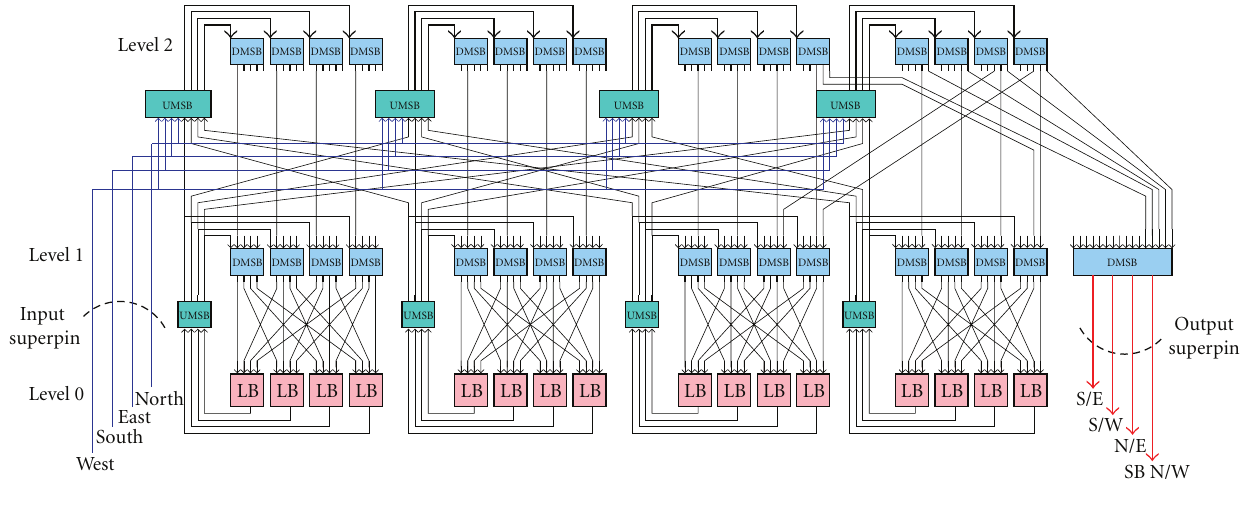
Figure 19: Cluster interface: external input and output connections.